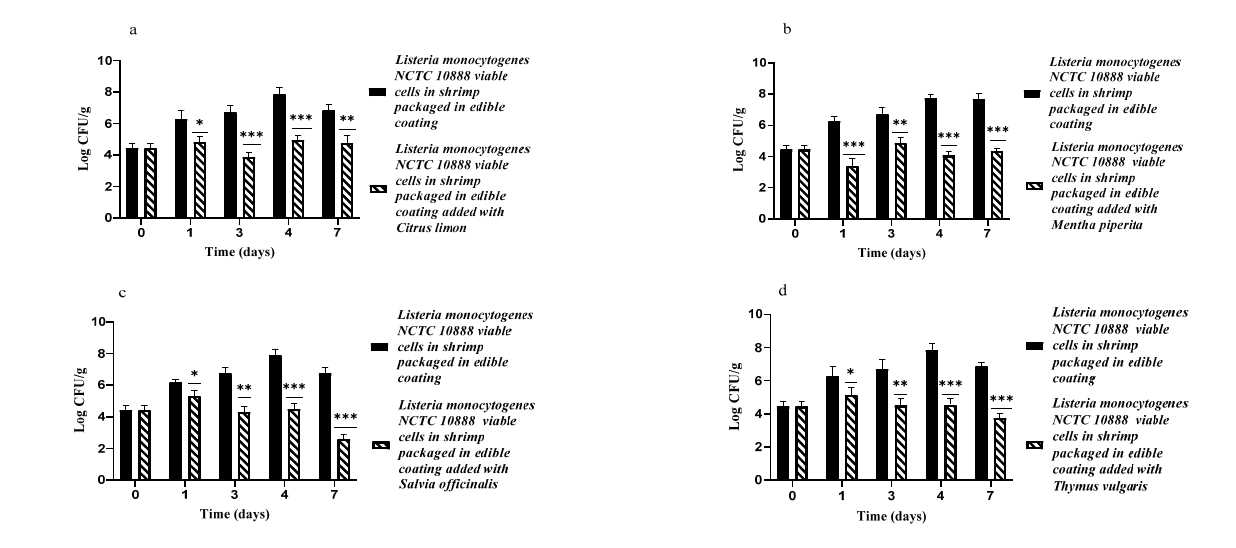
Figure 1. Coating added with EOs by themselves and at the respective MIC values, applied on artificially contaminated shrimp samples: Citrus lemon ( a ), Menta piperita ( b ), Salvia officinalis ( c ), Thymus vulgaris ( d ). Experiments were performed in triplicate. p -values of <0.05 (*), p < 0.01 (**) and p < 0.001 (***) were considered significant by t -test and ANOVA.